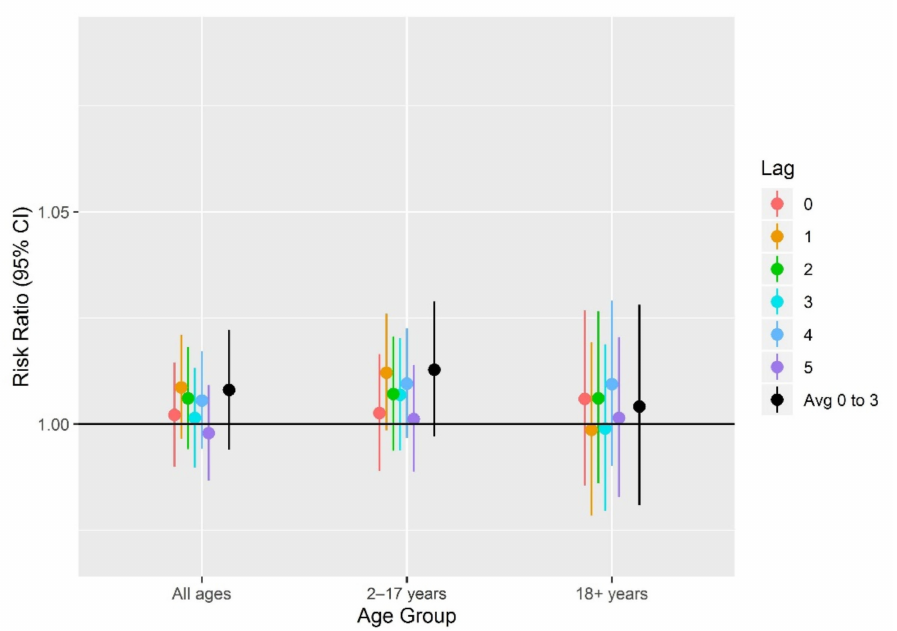
Figure 3. Risk Ratios of respiratory ED visits in Mexico City corresponding to one interquartile increase in nitrogen dioxide (NO 2 ) concentration, by lag structure and age group. Associations of NO 2 with population-level health risks are not as consistent as observed for PM 2.5 and O 3 . Significant associations were observed among children, but not adults, for individual lag days. Average effects at lag days 0–3 show positive, but not significant, associations among children.